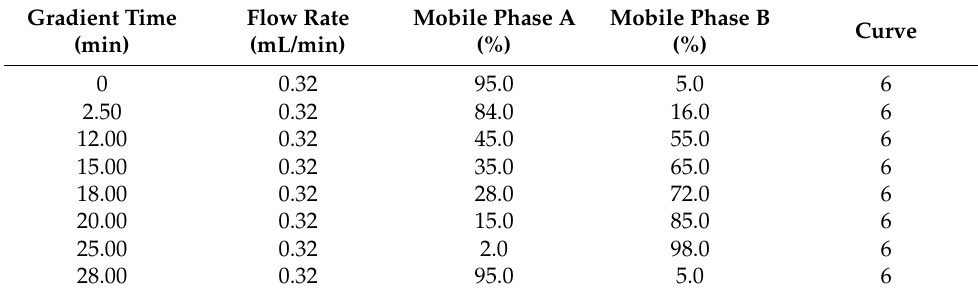
Table 2. Phase gradient